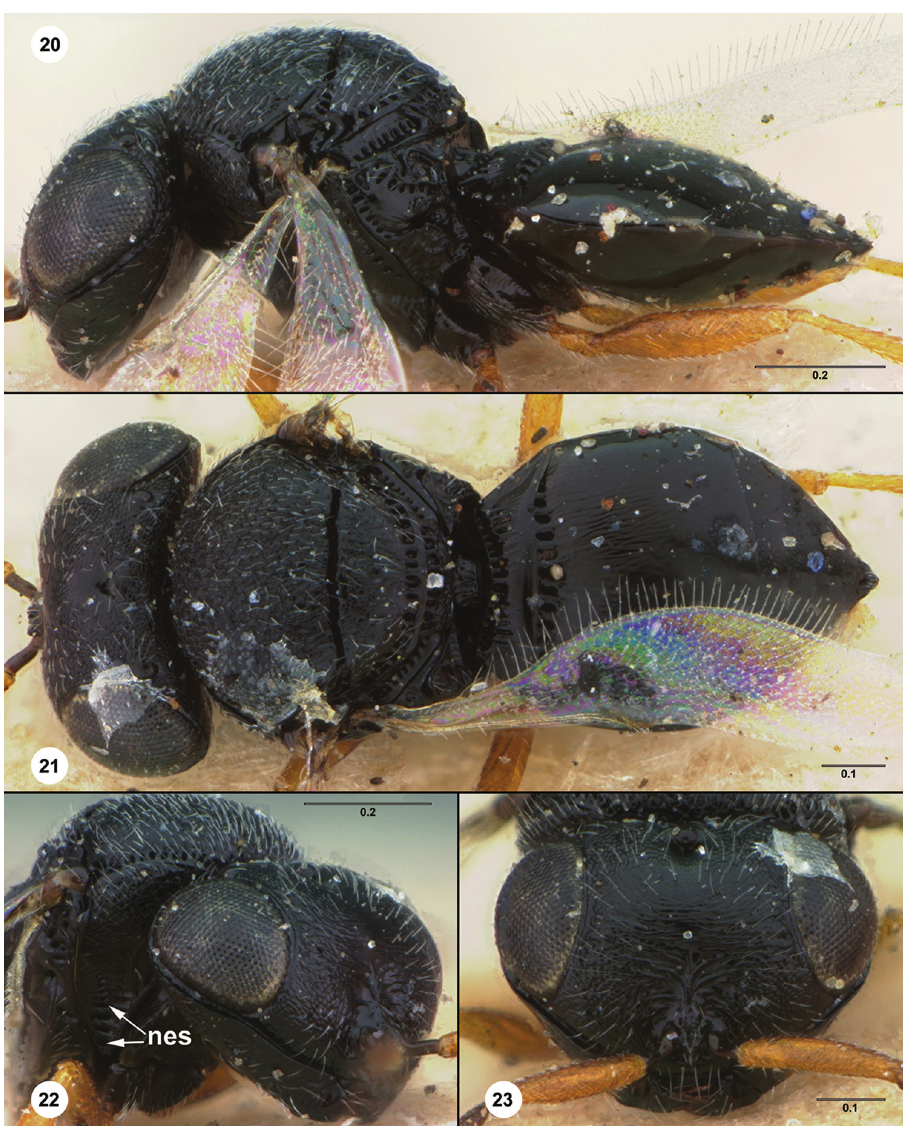
Figures 20–23. T. basalis , female lectotype (B.M. TYPE HYM. 9.304) 20 head, mesosoma, meta- soma, lateral view 21 head, mesosoma, metasoma, dorsal view 22 head and mesosoma, anterolateral view 23 head, anterior view. Scale bars in